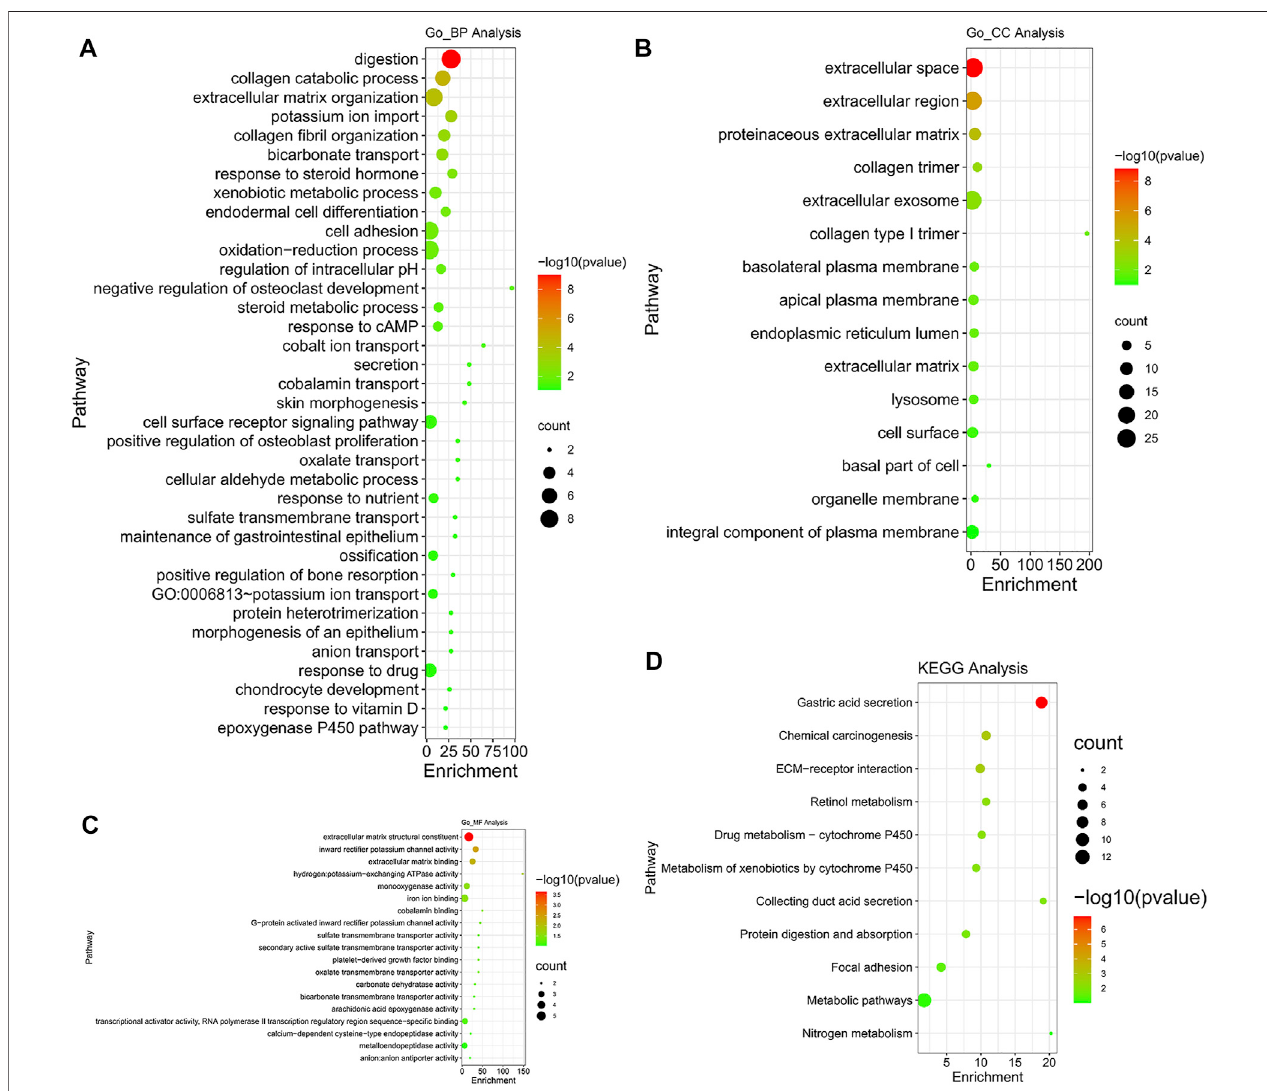
FIGURE8| GeneOntology(GO)enrichmentandKyotoEncyclopedia ofGenesandGenomes(KEGG)pathway analysis(DAVID).GOenrichmentanalysisoftarget genes based on (A) biological process, (B) cellular component, and (C) molecular function. (D) KEGG pathway enrichment analysis of target genes.